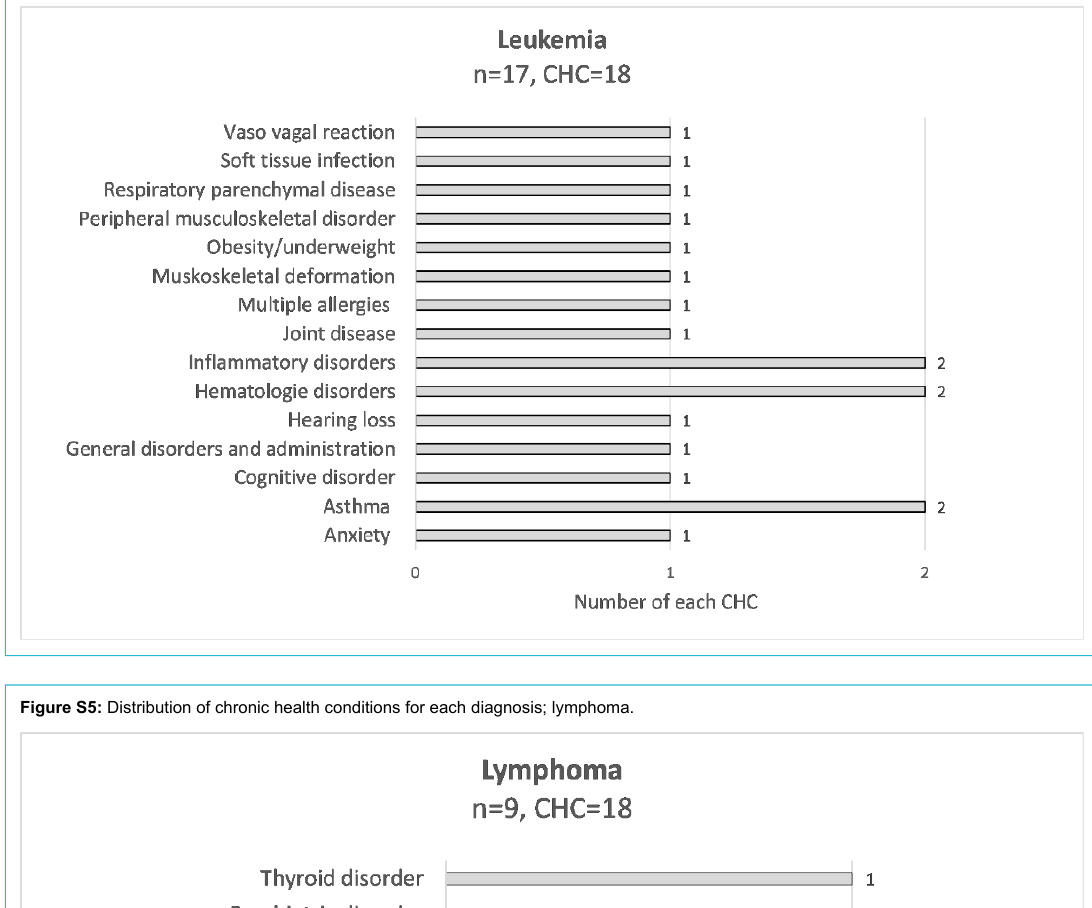
Figure S4: Distribution of chronic health conditions for each diagnosis; leukemia.